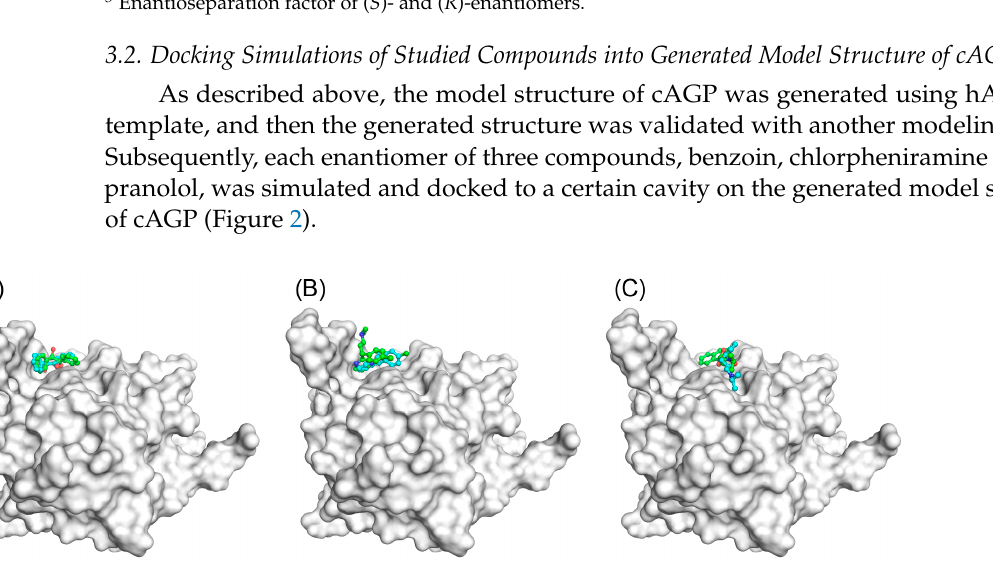
Figure 3. Simulated docking structures of cAGP focusing on the surrounding of bound ( A ) ( R )- benzoin and ( B ) ( S )-benzoin. The docked compounds were represented in either green or cyan for carbon atoms. Besides, nitrogen and oxygen atoms were colored in blue and red, respectively. The remarked amino acid residues were labeled and shown in gray for carbon atoms, and feasible in- teractions were depicted as dotted lines. As shown in Figure 3, both ( R )- and ( S )-benzoin were docked onto a similar position of a cavity of the generated model structure of cAGP. The positions seemed to be fastened by one of aromatic rings in both configurations by hydrophobic interactions. Furthermore, some of hydrogen bonding interactions work for chiral recognition of ( R )- and ( S )-ben- zoin. A carbonyl group of ( R )-benzoin is close to oxygen atoms in either a carbonyl or hydroxyl group of D161 with a distance of 3.2 or 4.9 Å, and a hydroxy group of Y47 is nearby a carbonyl group of ( R )-benzoin with a distance of 2.8 Å (Figure 3A). An oxygen atom in either a carbonyl or hydroxyl group of D161 is also close to a carbonyl group of ( S )-benzoin at a distance of 2.8 Å; however, Y47 is a bit far from the bound ( S )-benzoin at